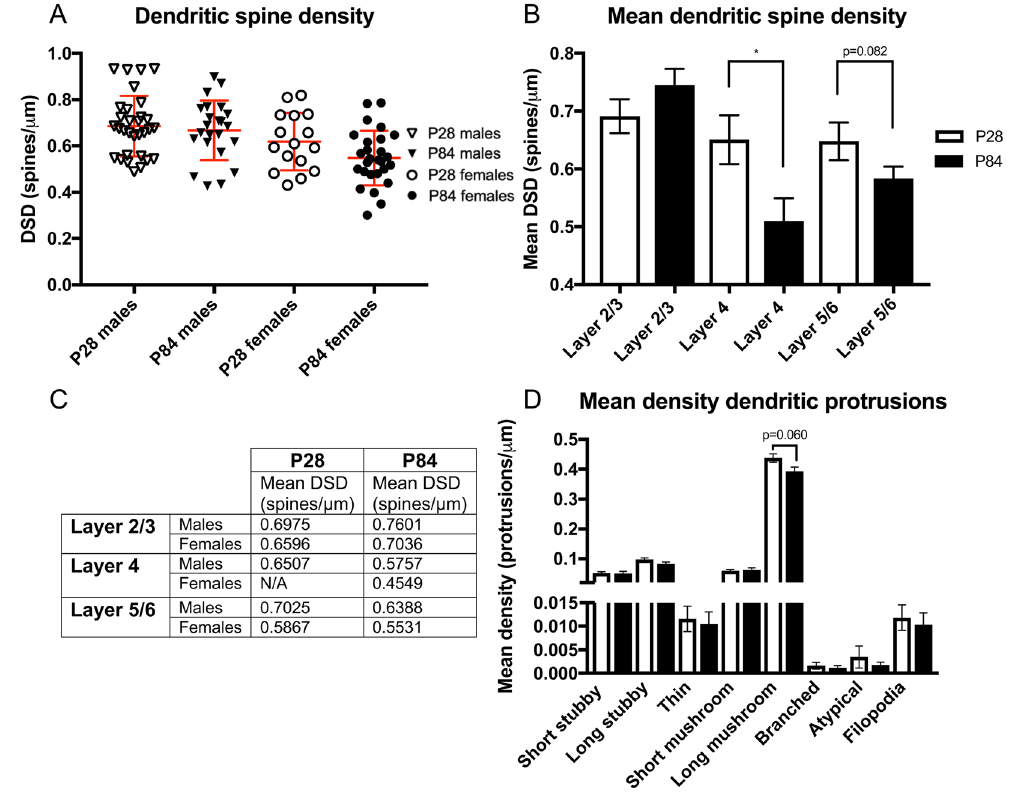
Figure 2. DSD and mean density dendritic protrusion findings over adolescent brain development. ( A ) DSD is not significantly changed in male and female mice from P28 to P84 (F = 0.001, DF = 1, p = 0.971). Data points are DSD from individual neurons. Mean DSD and SD represented by red lines. ( B ) There is a significant age by layer interaction (F = 0.777, DF = 2, p = 0.043). Mean DSD is unchanged from P28 from P84 in L2/3 (F = 1.516, DF = 1, p = 0.229), significantly decreased in L4 (F = 5.880, DF = 1, p = 0.026) and unchanged in L5/6 (F = 3.082, DF = 1, p = 0.086) over this period. Error bars = SEM. ( C ) Table demonstrating mean DSD of males and females at P28 and P84 show same laminar patterns of mean DSD shown in Fig. 2B; the age by sex by layer interaction was not significant. ( D ) Long mushroom mean density is nearly significantly reduced over adolescent neurodevelopment (F = 3.615, DF = 1, p = 0.060) with no significant age by sex interactions. Error bars =